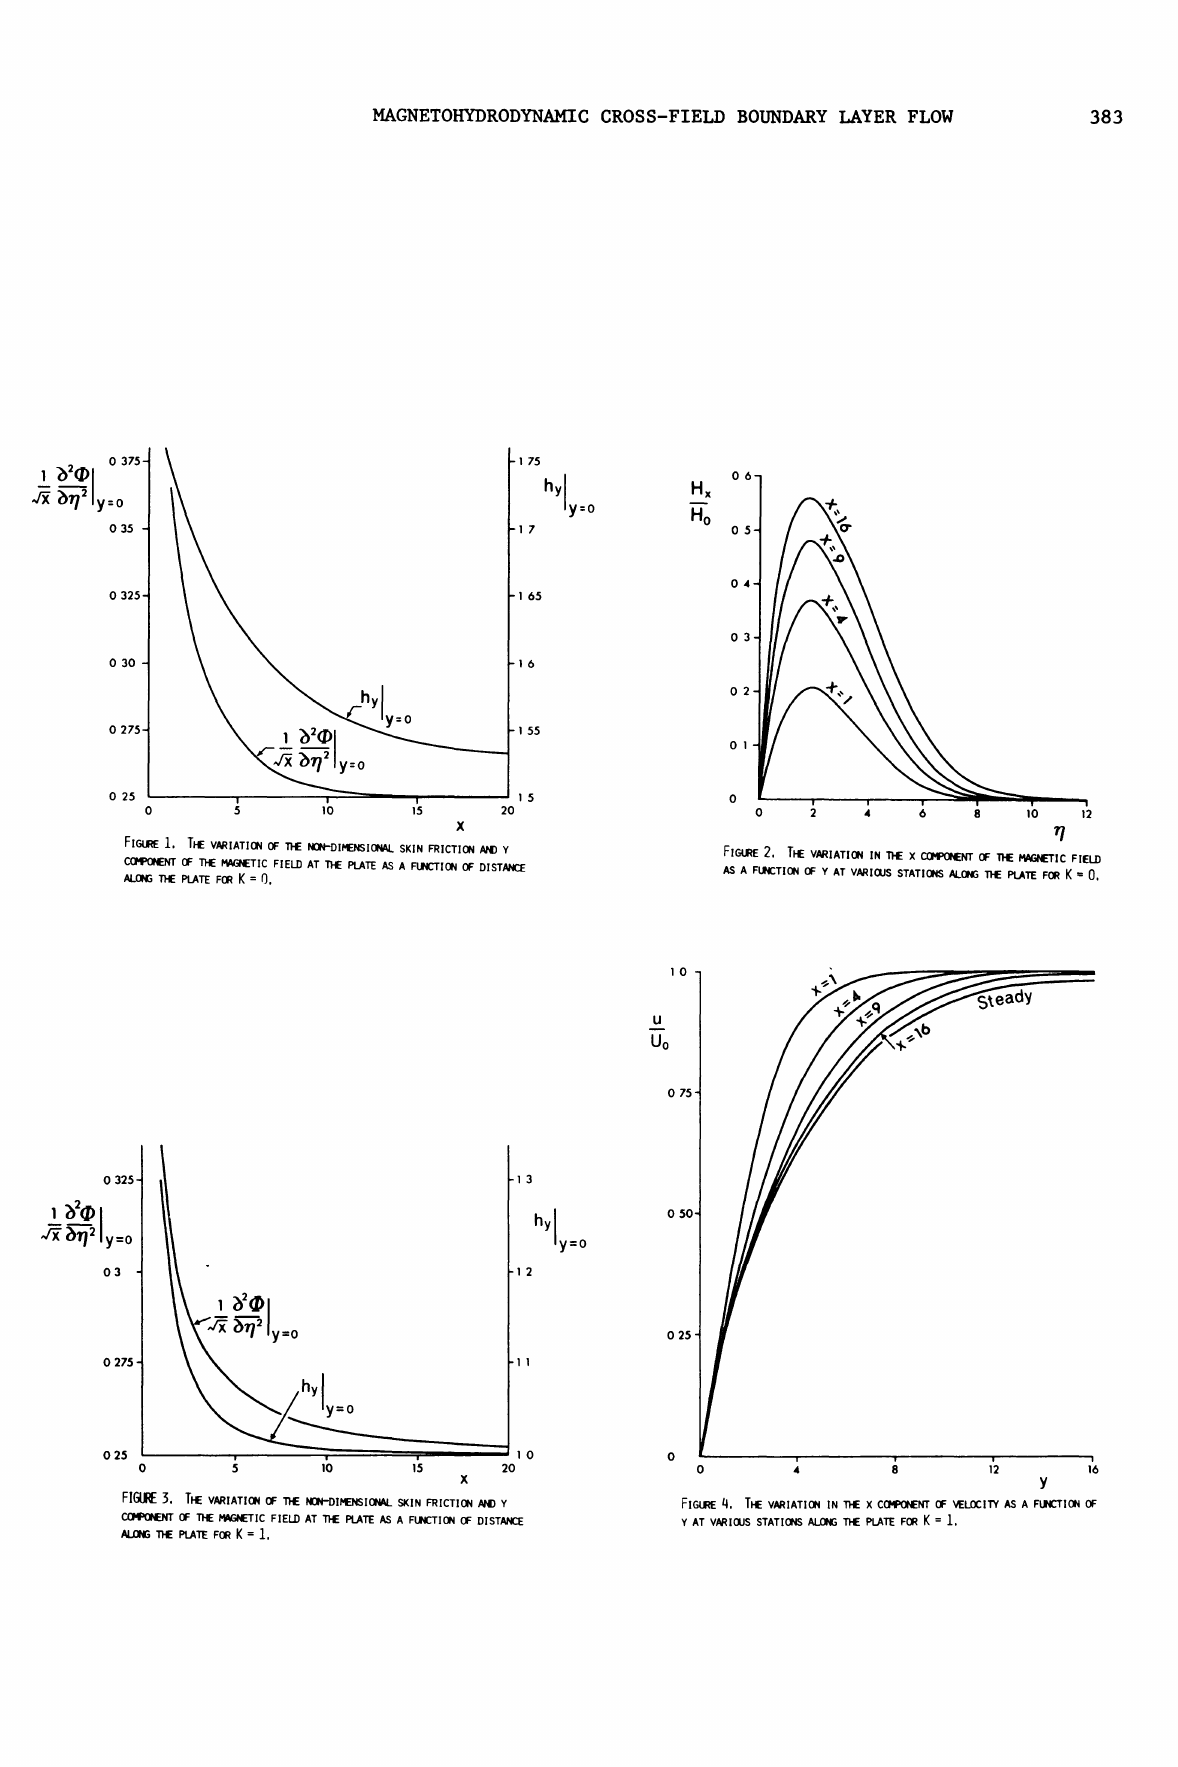
FIGIJRE 3. THE VARIATION